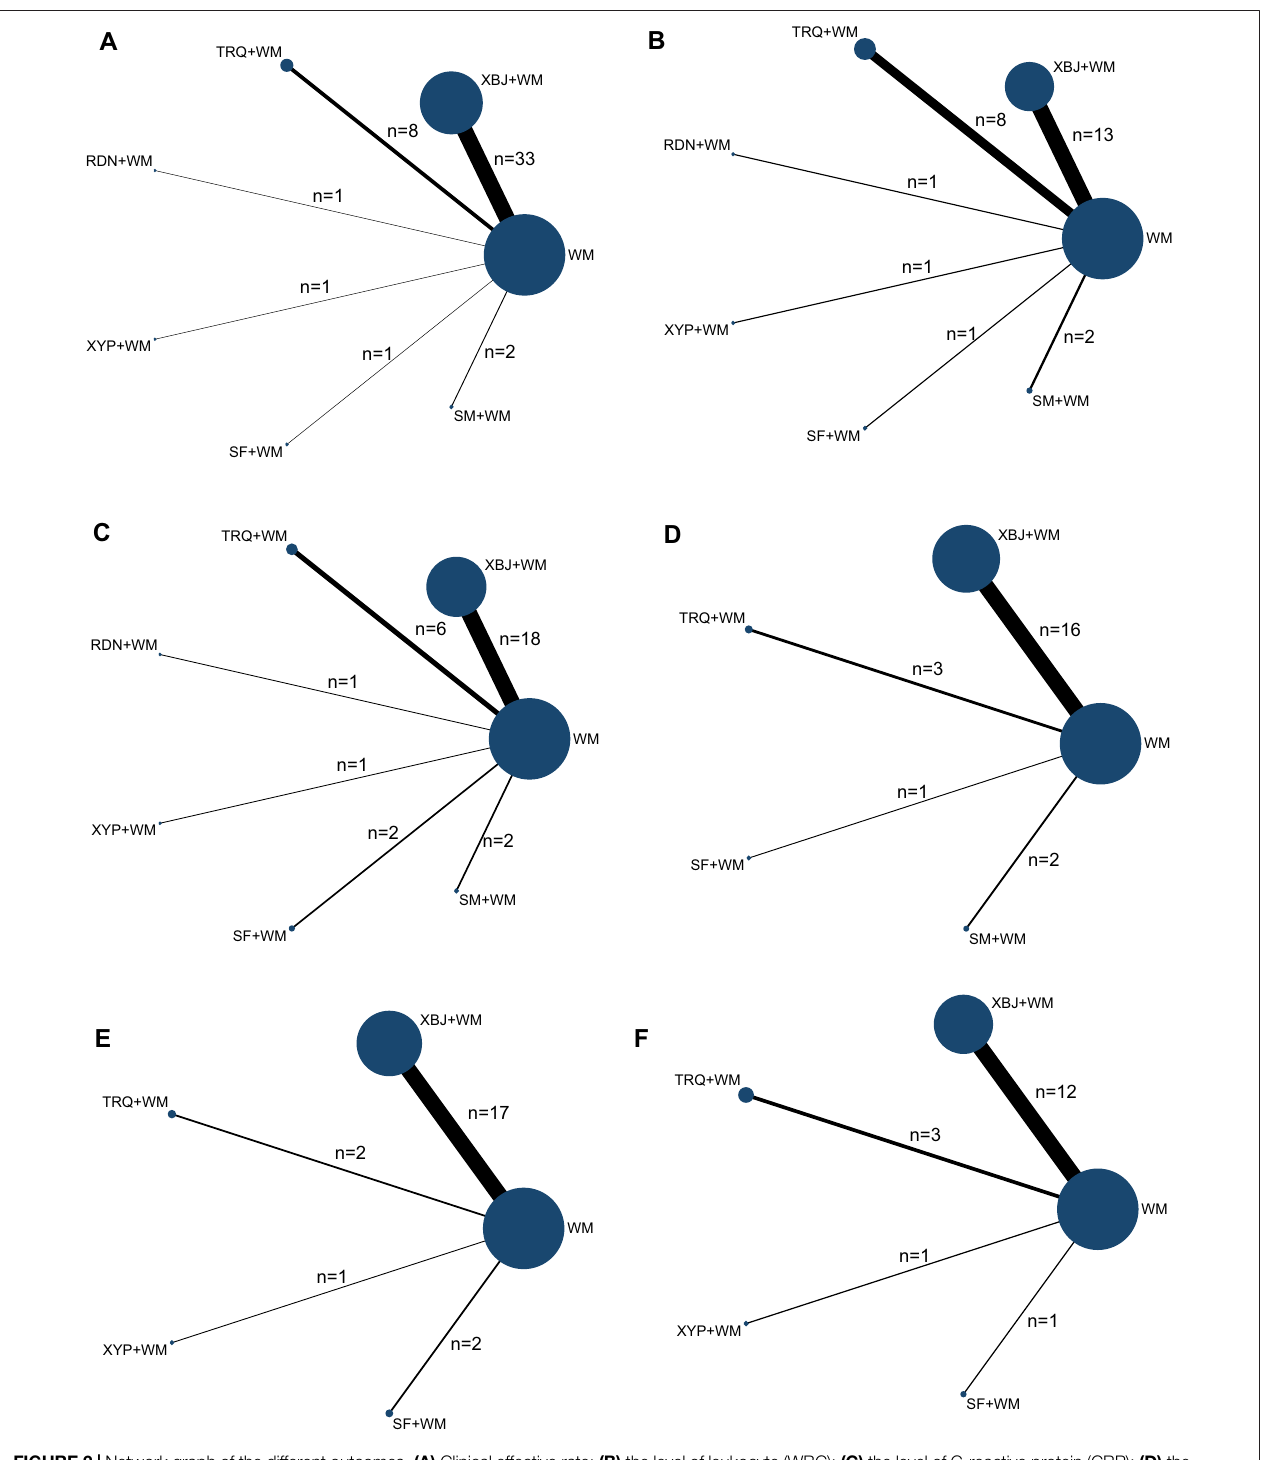
FIGURE 2 | Network graph of the different outcomes. (A) Clinical effective rate; (B) the level of leukocyte (WBC); (C) the level of C-reactive protein (CRP); (D) the level of procalcitonin (PCT); (E) intensive care unit (ICU) length of stay; and (F) the time of mechanical ventilation.